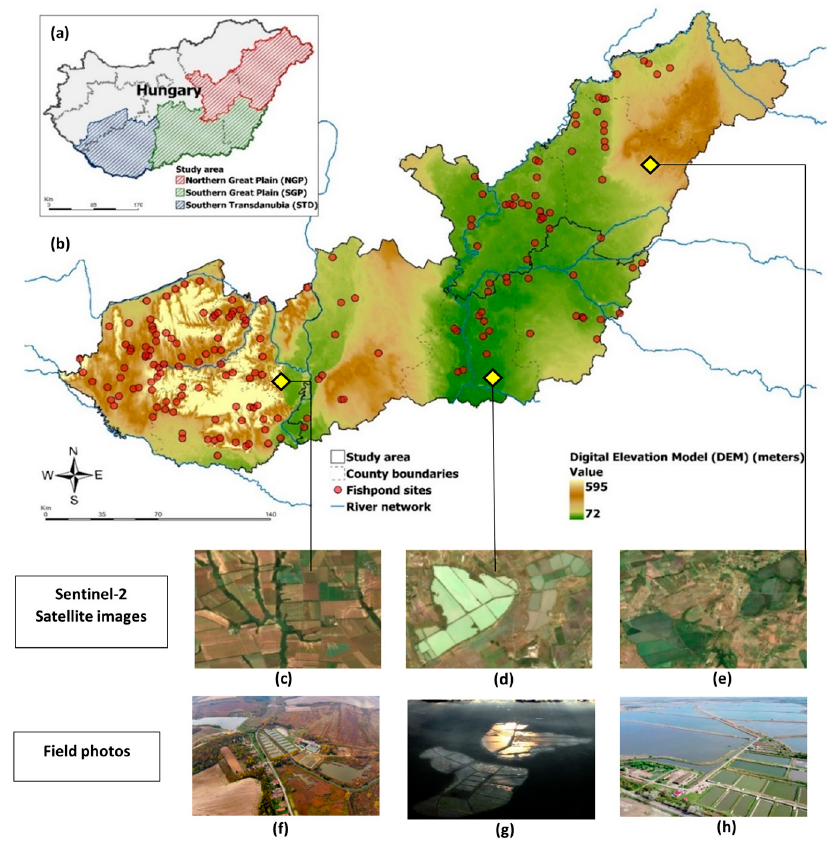
Figure 1. General information on the study area: ( a ) the NUTS-2 regions and the regions selected as the study area; ( b ) the three main fish production regions in Hungary and their topography; ( c – e ) Sentinel-2 images showing typical examples of fish pond structure; ( f – h ) field photographs of the fish ponds in ( c , f ) STD, ( d – g ) the SGP, and ( e – h ) the NGP. Water management regimes differ significantly for ponds in hilly (STD) and flat (NGP and SGP)